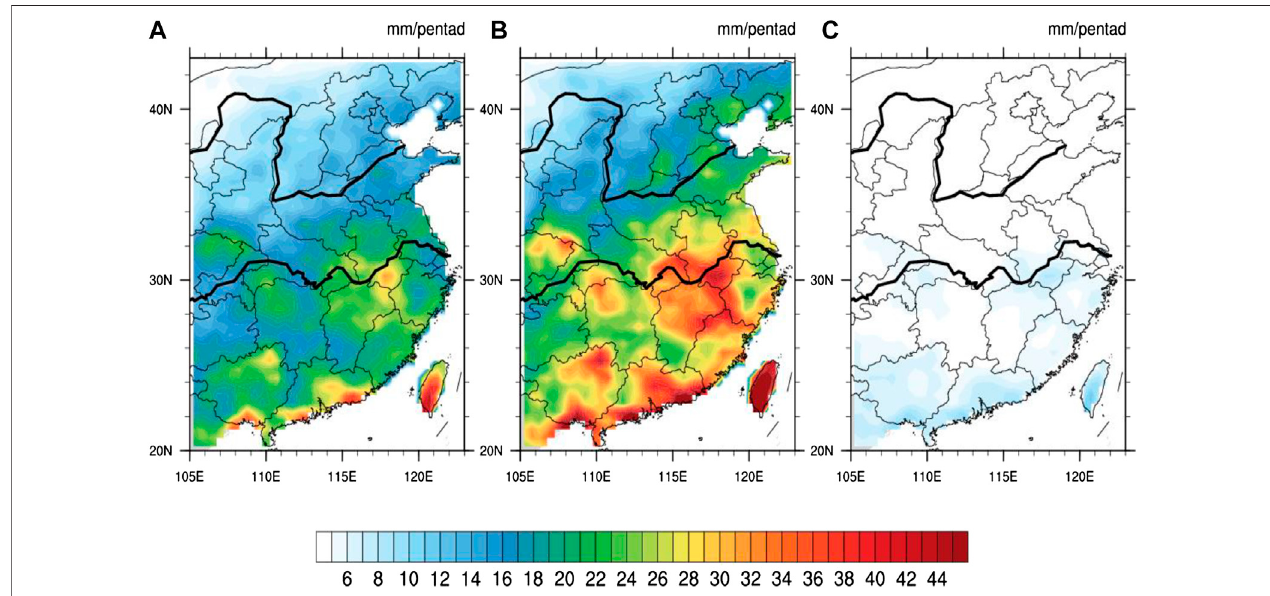
FIGURE1| Thespatialdistributionsofthresholdaccordingto95thpercentileofpentadprecipitation (A) ,meanintensityofRPEP (B), andcommonsummerpentad precipitation (C) during summer from 1979 to 2019 (unit: mm per pentad).